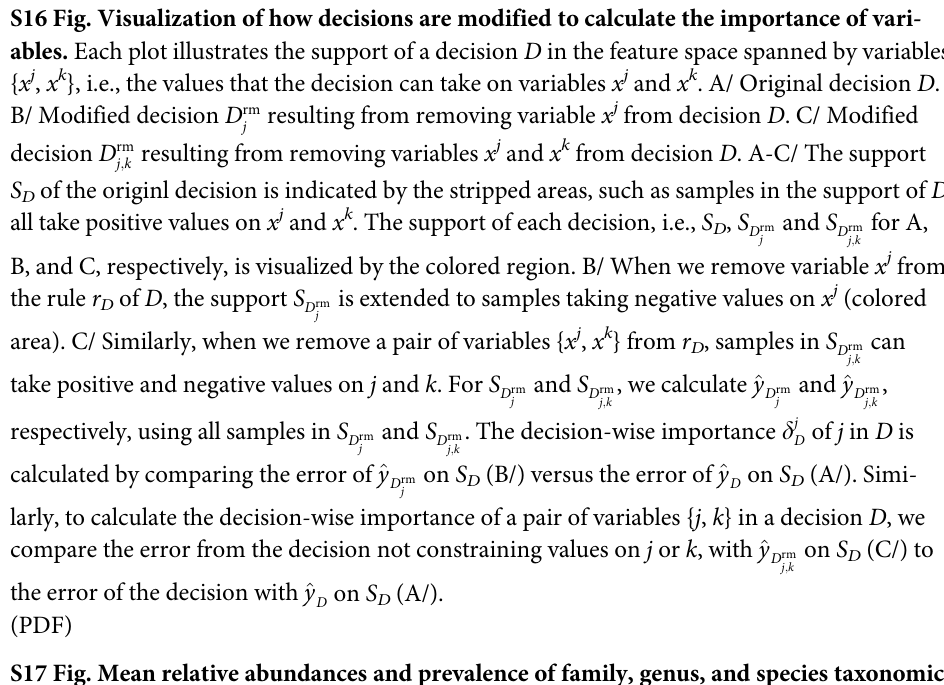
in human guts microbiome from 2203 individuals for involved in H metabolism. The number 2 of copies of genes involved in the following pathways or function were counted: sulfate reduc- tion (SRB): dsrA and dsrB genes [82]; acetogenesis (Acetogen): fhs gene [83]; H production, 2 uptake and sensing as determined by the HydDB database [84]. At the genus and family taxo- nomic levels, we used the average number of copies across species from the given level and weighted the number of copies of each species by the average relative abundance of species in the dataset. Accordingly, if the most abundant species of a specific genus had high number of gene copies, the number of copies for that genus would also be high. When genes were grouped by general function, we summed the number of copies (e.g., the SRB gene copy num- ber corresponds to the sum of gene copies of dsrA and dsrB ). A/ The ratios of gene copy num- ber by genome size for each of the endoR selected features are consistent with the absolute number of copies displayed in Fig 6B. For each representative species, the number of gene cop- ies was divided by the genome size. General functions and genes are displayed and separated by black lines (blocks of genes with the same general function), general functions are separated from specific genes by a grey line. B/ Number of genes copies from each group for taxa selected by feature selection. C/ Occurrence of genes from each group across all taxonomic features used to train models to predict the occurrence of Methanobacteriaceae in human guts. S16 Fig. Visualization of how decisions are modified to calculate the importance of vari- ables. Each plot illustrates the support of a decision D in the feature space spanned by variables { x j , x k }, i.e., the values that the decision can take on variables x j and x k . A/ Original decision D . B/ Modified decision D rm resulting from removing variable x j from decision D . C/ Modified j decision D rm resulting from removing variables x j and x k from decision D . A-C/ The support j ; k of the originl decision is indicated by the stripped areas, such as samples in the support of D S D all take positive values on x j and x k . The support of each decision, i.e., S , S and S for A, D D rm j D rm j ; k B, and C, respectively, is visualized by the colored region. B/ When we remove variable x j from the rule r of D , the support S is extended to samples taking negative values on x j (colored D D rm j area). C/ Similarly, when we remove a pair of variables { x j , x k } from r , samples in S can D D rm j ; k take positive and negative values on j and k . For S and S , we calculate ^ y and ^ y , D rm j D rm j ; k D rm j D rm j ; k respectively, using all samples in S and S . The decision-wise importance d j of j in D is D rm j D rm j ; k D calculated by comparing the error of ^ y on S (B/) versus the error of ^ y on S (A/). Simi- D D D rm j D larly, to calculate the decision-wise importance of a pair of variables { j , k } in a decision D , we compare the error from the decision not constraining values on j or k , with ^ y on S (C/) to D D rm j ; k the error of the decision with ^ y on S (A/). D D S17 Fig. Mean relative abundances and prevalence of family, genus, and species taxonomic levels in the metagenomic data. S18 Fig. Gut microbiota of a large cohort of healthy individuals (n = 2203 individuals) approximately segregate along the enterotype landscape. A-C, H-K/ Principal coordinate analysis ordination of the Jensen-Shannon distance matrix computed from genera relative abundances. A-B/ Samples colored by relative abundance (RA) of Bacteroides and Prevotella , respectively. To calculate the log, a pseudocount equal to the minimal non-null RA was given to samples for which the genus was not detected, i.e., RA = 0. C/ Samples colored by